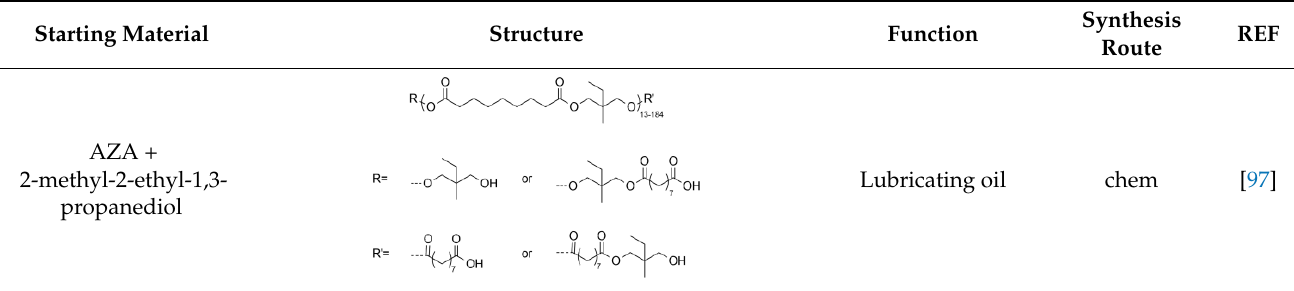
Table 3. Structure, function and synthesis route of AzA-based lubricants and plasticizers. Starting Material